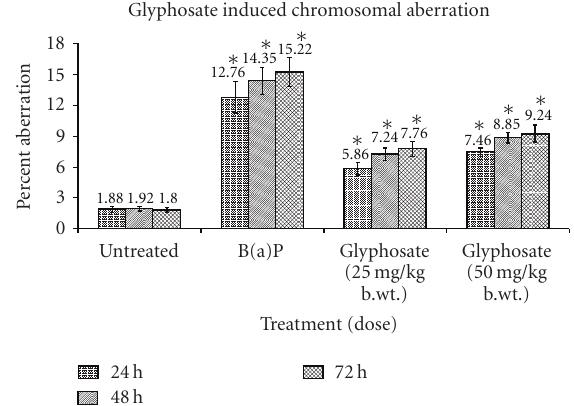
Figure 2: Mutagenic activity of glyphosate in Swiss albino mice showing incidence of aberrant cells at sampling time of 24, 48, and 72 hours. Values are expressed as mean ± SE of 5 animals. ∗ Represent significant increase over untreated control group at their respective sampling time. Data are significant as P < .05.